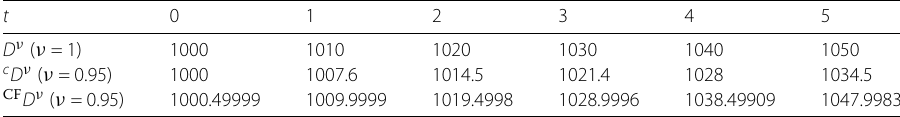
Table 1 Results of three types of derivative: ordinary derivative D ν , Caputo fractional derivative c D ν , and Caputo–Fabrizio fractional derivative CF D ν for T ( t )